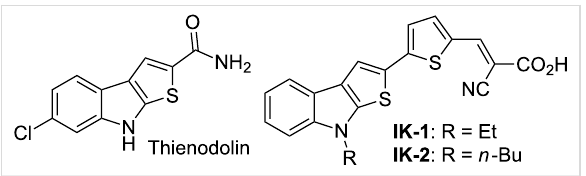
Figure 1: Natural and synthetic derivatives of thieno[2,3- b ]indole.